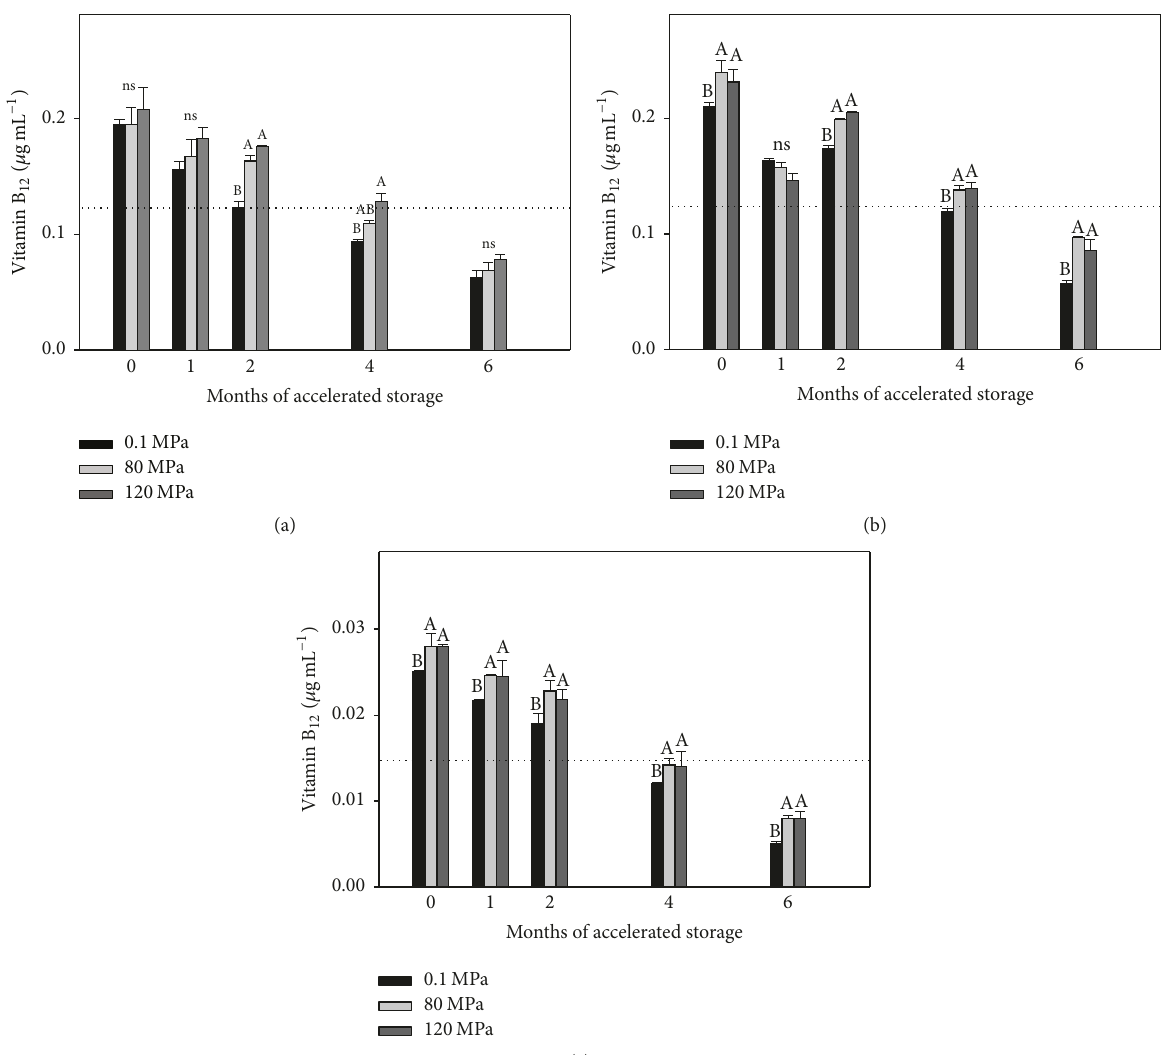
Figure 2: The effect of HPH treatments on the total vitamin B 12 content of artichoke (a), royal jelly (b), and iron food supplements (c) stored at 40 ∘ C ± 2 ∘ C and 75% ± 5% RH. Mean ( 𝑛 = 3 ± SD). Different letters within the same day indicate significant differences between pasteuri- zation and HPH treatments at 𝑝 ≤ 0.05 . ns: not significant. The dotted line indicates 50% vitamin losses with respect to the initial contents shown in Table